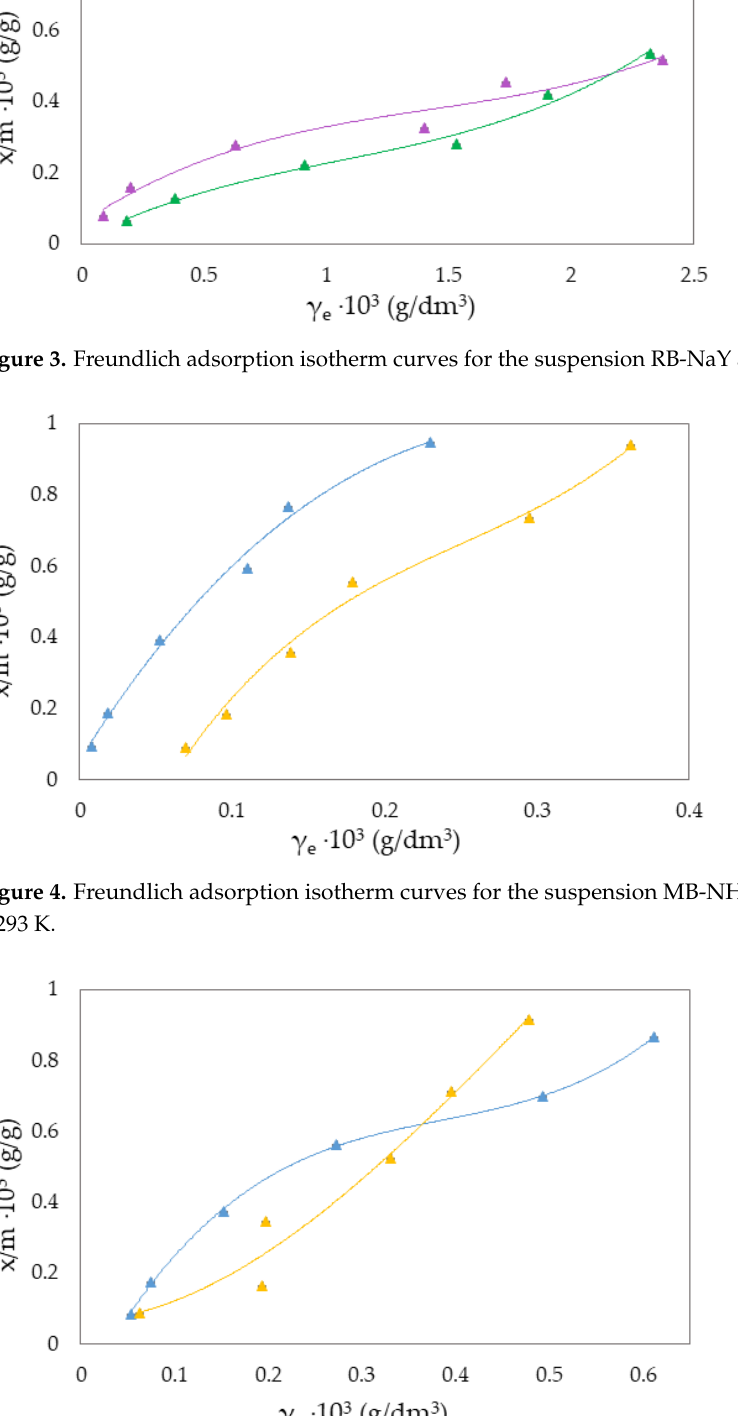
Figure 5. Freundlich adsorption isotherm curves for the suspension MB-NH 4 ZSM-5 at ▲ 283 K and ▲ 293 K.